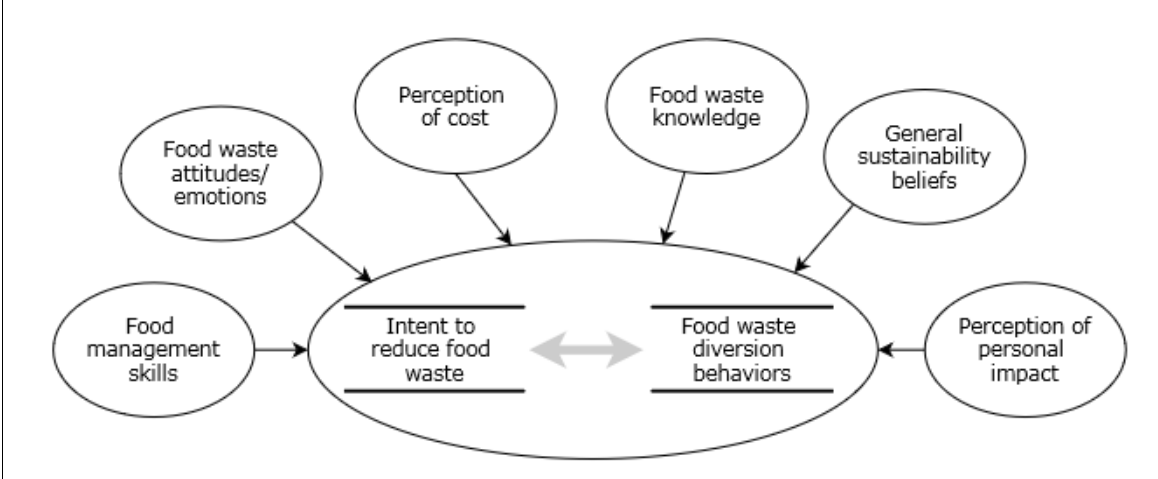
Figure 1. A Simplified Conceptual Figure of Various Underlying Factors that Influence Food Waste Diversion